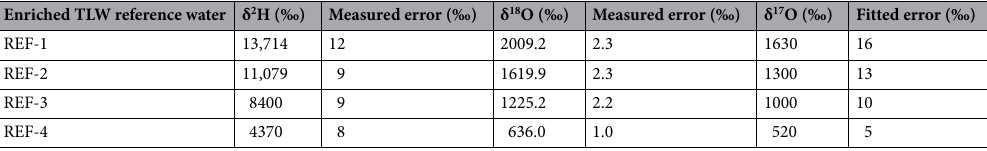
Table 1. Isotope δ-values of the enriched TLW reference waters. The δ 2 H and δ 18 O values were measured by OA-ICOS and calibrated using the IAEA-reference waters. The δ 17 O values are based on several dilution experiments, with a relative uncertainty of ± 1% attributed to